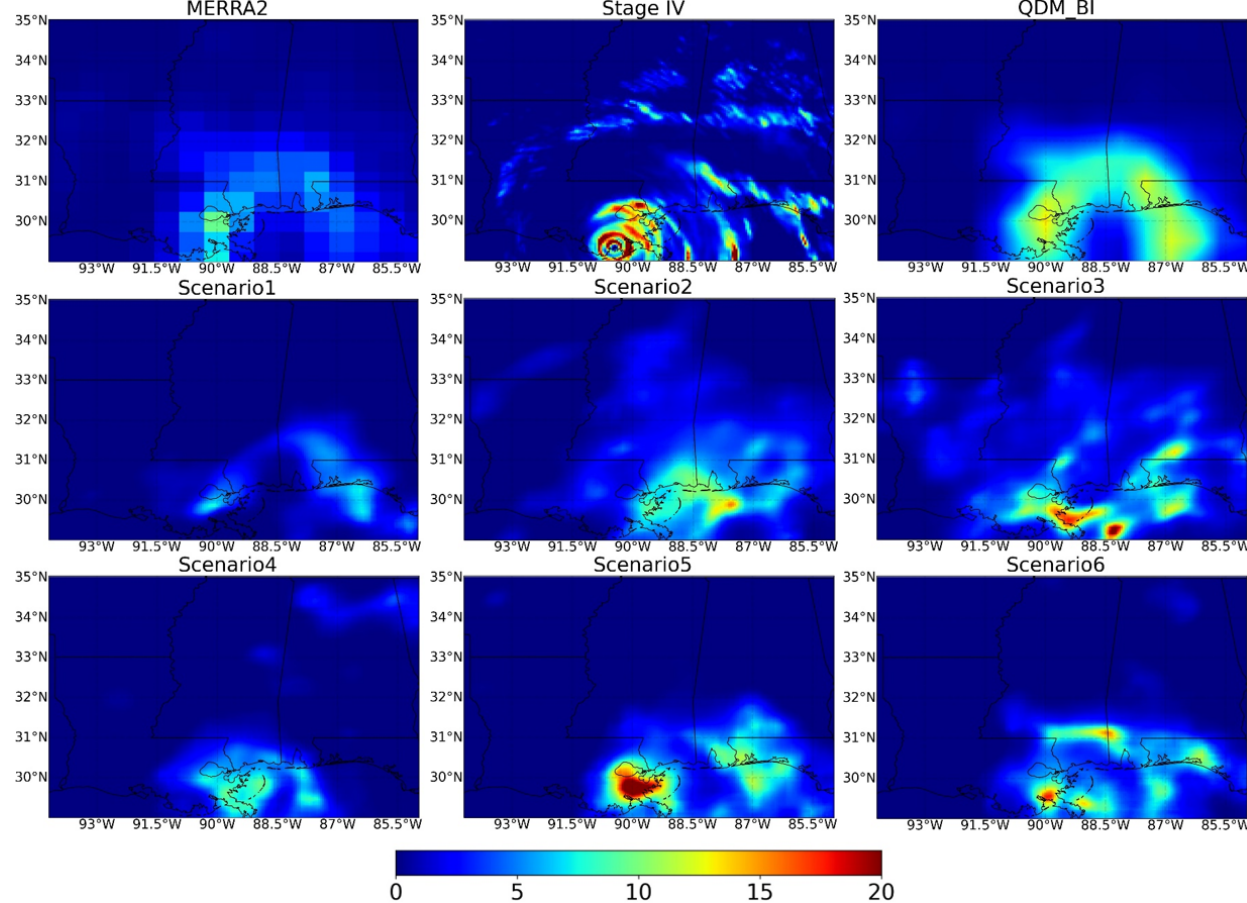
Figure 8. Hourly precipitation (in a unit of mmh − 1 ) from 19:00 to 20:00 on 29 August 2021 in UTC time zone when Hurricane Ida landed in Louisiana, including raw MERRA2, Stage IV, QDM_BI and the 6 DL experimental runs